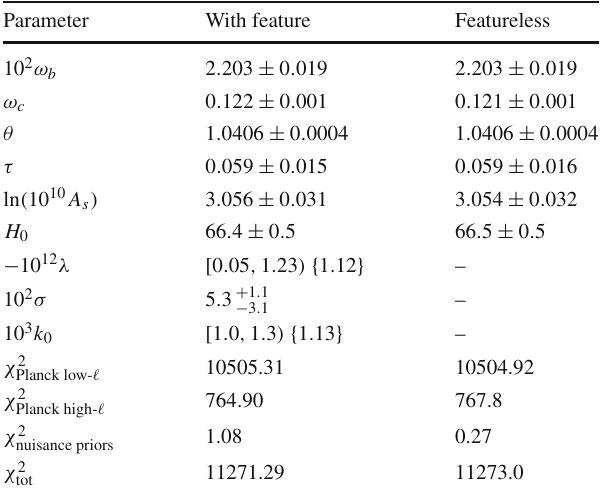
Fig. 4 The = (cid:14)((cid:14) + 1 ) C TT /( 2 π) D TT (cid:14) l spectrum in units of μ K 2 is plotted as a function of the multipole l . We compare the best fit obtained using the inflationary model without feature ( red line ) to the one obtained introducing the local feature ( black line ). In the lower panel we plot the relative difference with respect to the featureless case. The data points are from the 2015 Planck release [37]. The cosmological parameters used to compute the two spectra are reported in